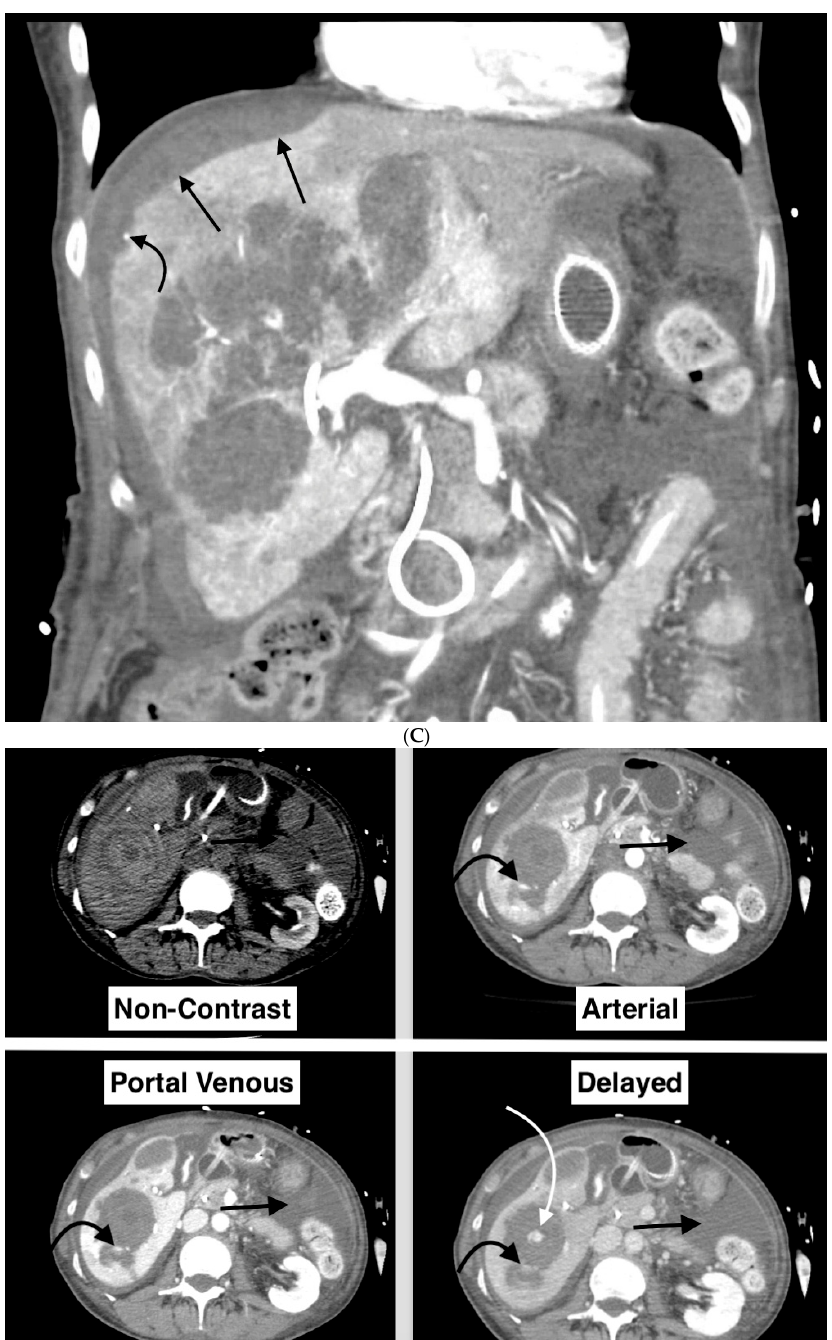
Figure 7. 69-year-old female with PTBD complicated by liver lacerations and subsequent death. Patient had malignant obstructive jaundice secondary to esophageal cancer. Pre-procedure images, including ultrasound ( A ) and CT ( B ), showed significant biliary ductal dilation (white arrows). Note the expected proximity of the hepatic artery (straight black arrow in A ) and portal vein (curved black arrows in B ). Despite seemingly uncomplicated placement of bilateral biliary drainage catheters, the patient decompensated 3 h later. ( C , D ) Multiphase CT showed hemoperitoneum (straight black arrows), focal areas of arterial extravasation (curved black arrows) and venous pooling (curved white arrow in D ). Multiple large intrahepatic lacerations were seen. Given patient’s overall prognosis and multifocal liver injuries, the patient was transitioned to comfort care and passed away 48 h